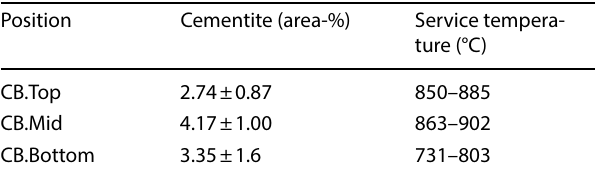
Table 2 Area-% of cementite and estimated service temperature at different positions in the collector bar